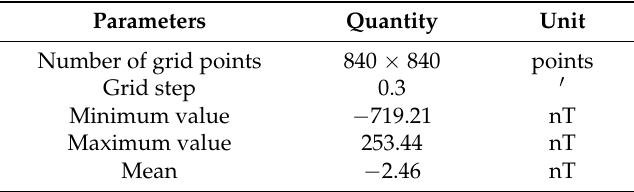
Figure 3. 3D map of the geomagnetic anomaly data. Table 2. Parameters of the geomagnetic base map.